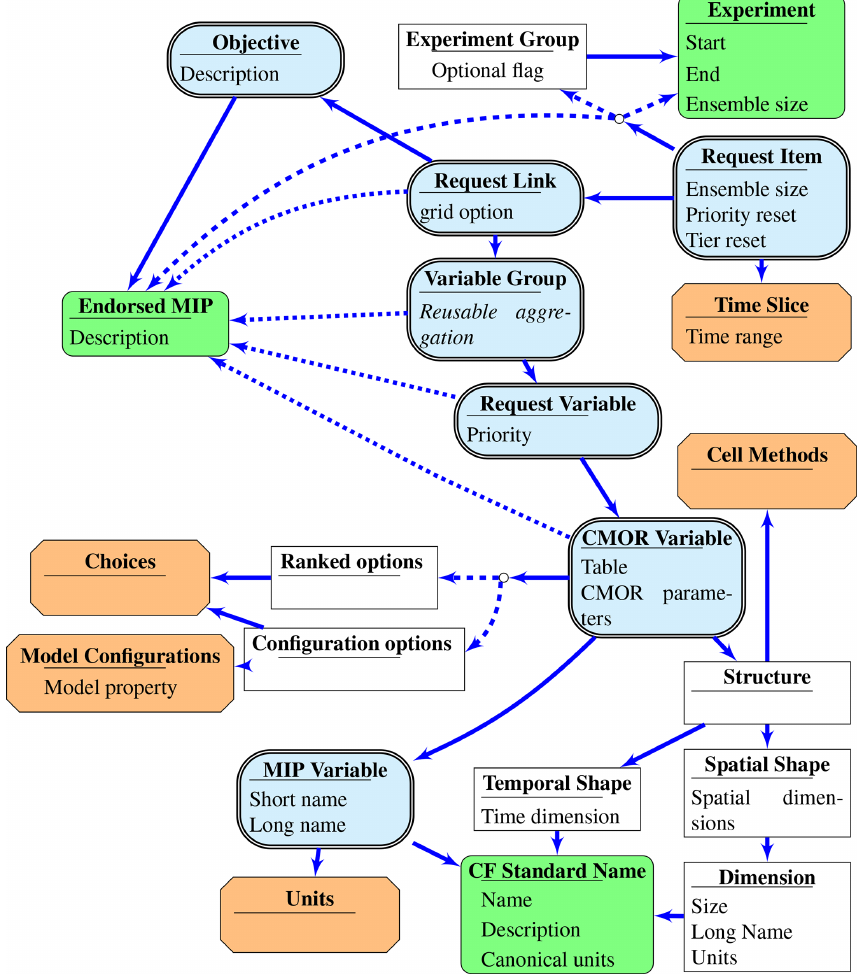
Figure 3. Main elements of the DREQ schema. The rounded double-edged blue shapes represent the core request elements (Sect. 4.2.1) which describe the central functionality of the DREQ: linking parameter definitions to objectives and specific experiments. The chamfered orange shapes are simple lists of terms (Sect. 4.2.2), and the green rounded boxes represent imported information (Sect.